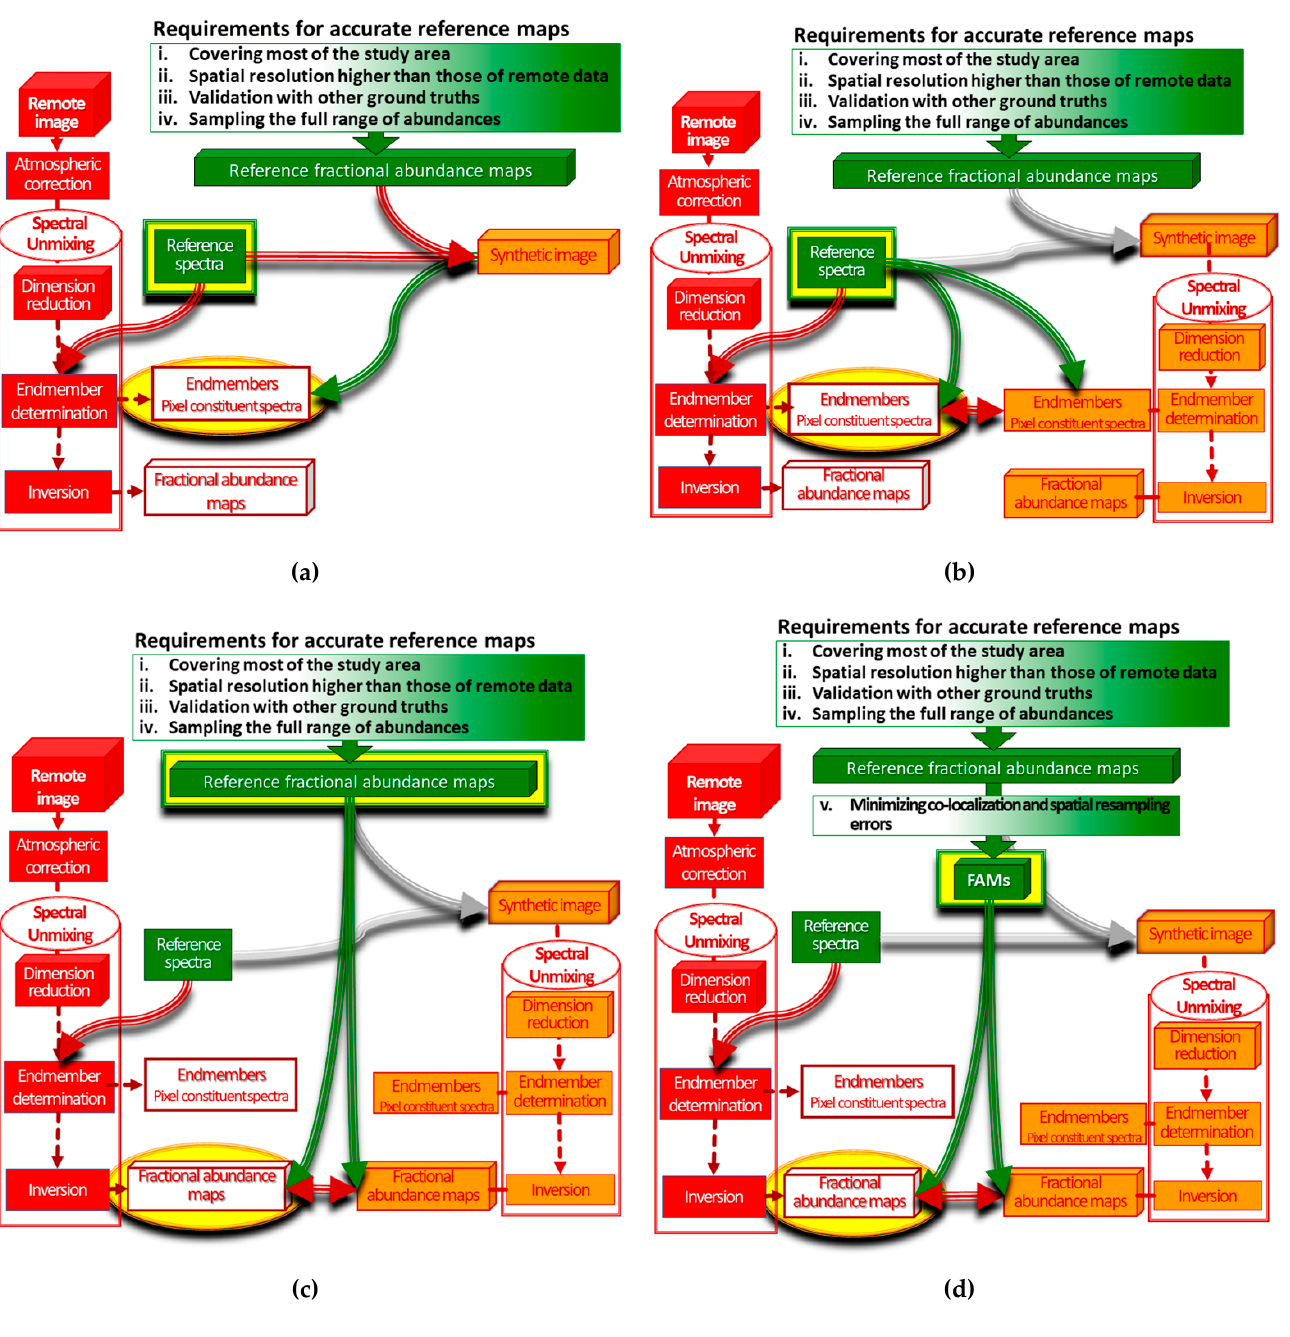
Figure 7. The flowcharts of the validation methods: ( a ) the second method; ( b ) the third method; ( c ) the fourth method; ( d ) the fifth method.